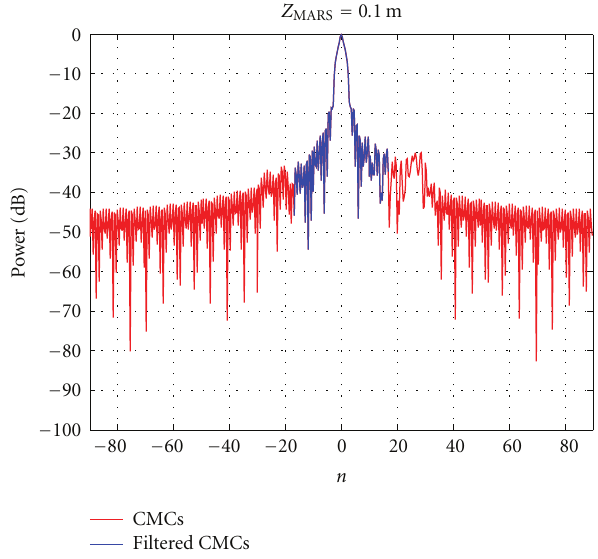
Figure 9: Equivalent CMCs with AUT displacement of